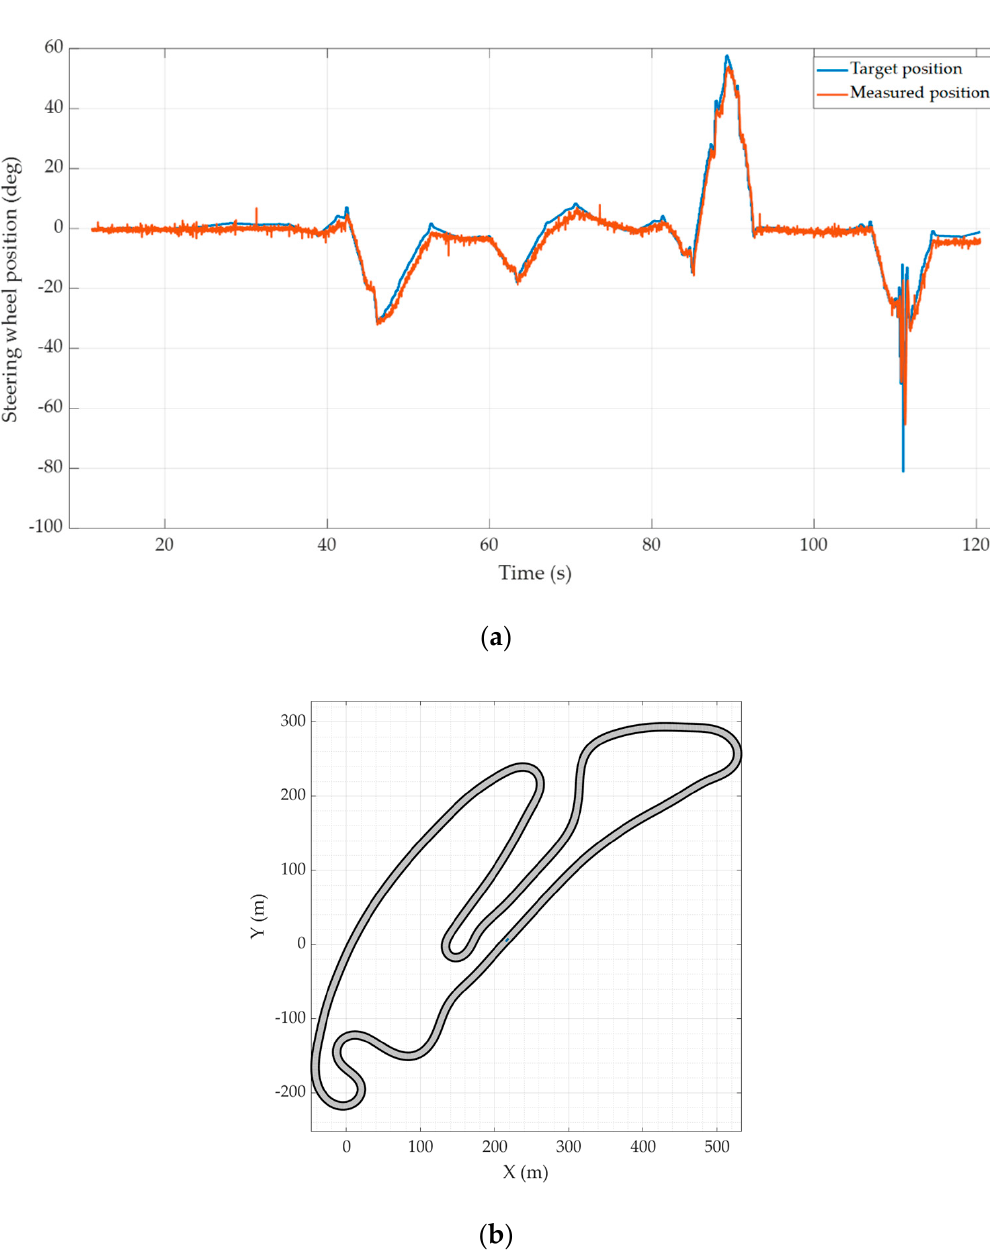
Figure 10. Autonomous driving test. ( a ) Steering wheel position measured by the encoder sensor (orange, solid) vs. target position generated by the MPC strategy devoted to autonomous driving (blue, solid). ( b ) Spatial coordinates (X,Y) of the race track related to the performed autonomous driving test.